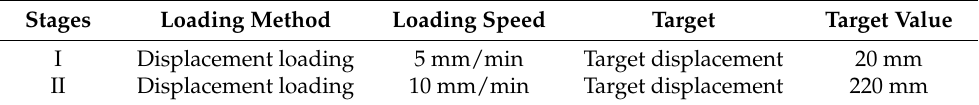
Figure 7. The stress–deformation curve of the LED. (1) Elastic rising stage. In this stage, the stress increases linearly with the compression deformation but is minimal, and the bending of the energy-absorbing steel plates is not apparent. Finally, the peak strength is 23.52 MPa. (2) Yield falling stage. In this stage, the stress decreases with the compression defor- mation, and the energy-absorbing steel plates yield and produce obvious bending deformation. (3) Yield constant resistance stage. In this stage, the stress remains constant and does not change with the compression deformation. The middle part of the energy-absorbing steel plates experiences a large bending deformation. The constant resistance is 3.50 MPa, and the total compression deformation is 206.00 mm.